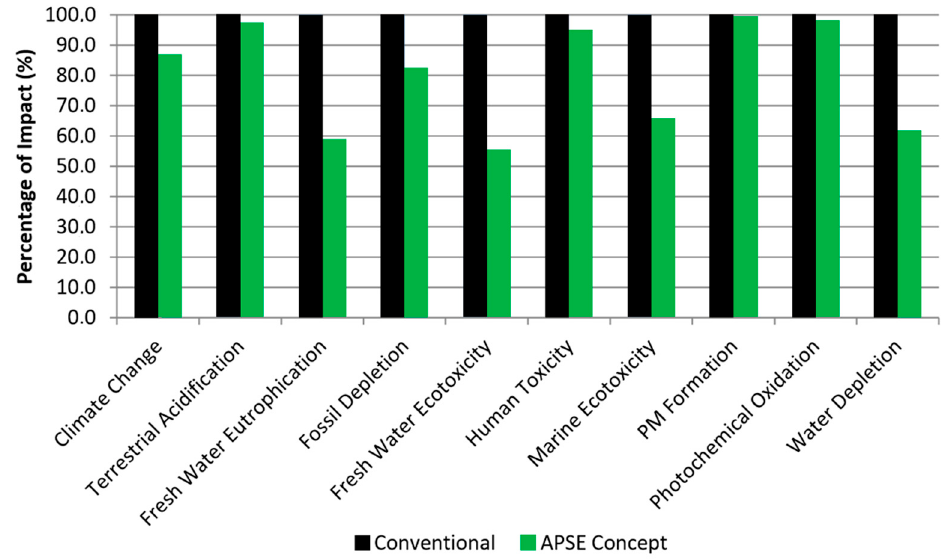
Figure 7. Results of LCIA, total significant impact over 60 years.